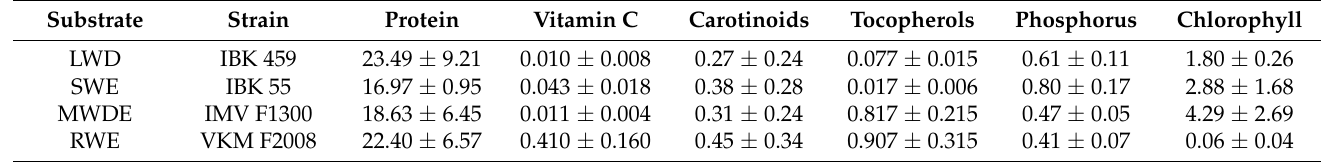
Table 6. Nutritional value of secondary plant wastes of floral and herbaceous raw materials after cultivation of A. bisporus, L. edodes , and P. ostreatus ,